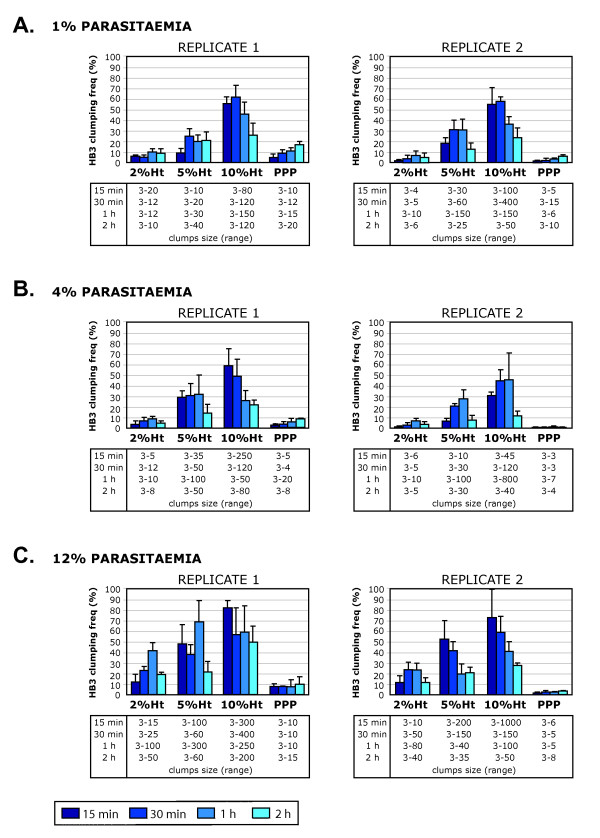
Comparison of HB3 platelet-mediated clumping frequencies detected by in vitro assays performed at a constant parasitaemia (Pt) but varying haematocrit (Ht). A. In vitro platelet-mediated clumping assays were set up at 1% Pt and varying Ht (2%, 5% and 10%) and the clumping frequency (percentage of IE in clumps out of at least 500 IE counted) was assessed by fluorescence microscopy of wet preparations at four time points (15 min, 30 min, 1 h and 2 h). The mean and standard deviation of three wet preparations from each time point are shown, and the range of clump sizes (number of IE forming the clump) detected in each assay and each time point is indicated. Two replicates of each experiment, done on different days and with platelet-rich plasma from different donors, are shown. Each experiment included a negative control performed with PPP (platelet-poor plasma) and 10% Ht to determine the potential for non-platelet mediated clumping. B. As above but at 4% Pt. C. As above but at 12% Pt.